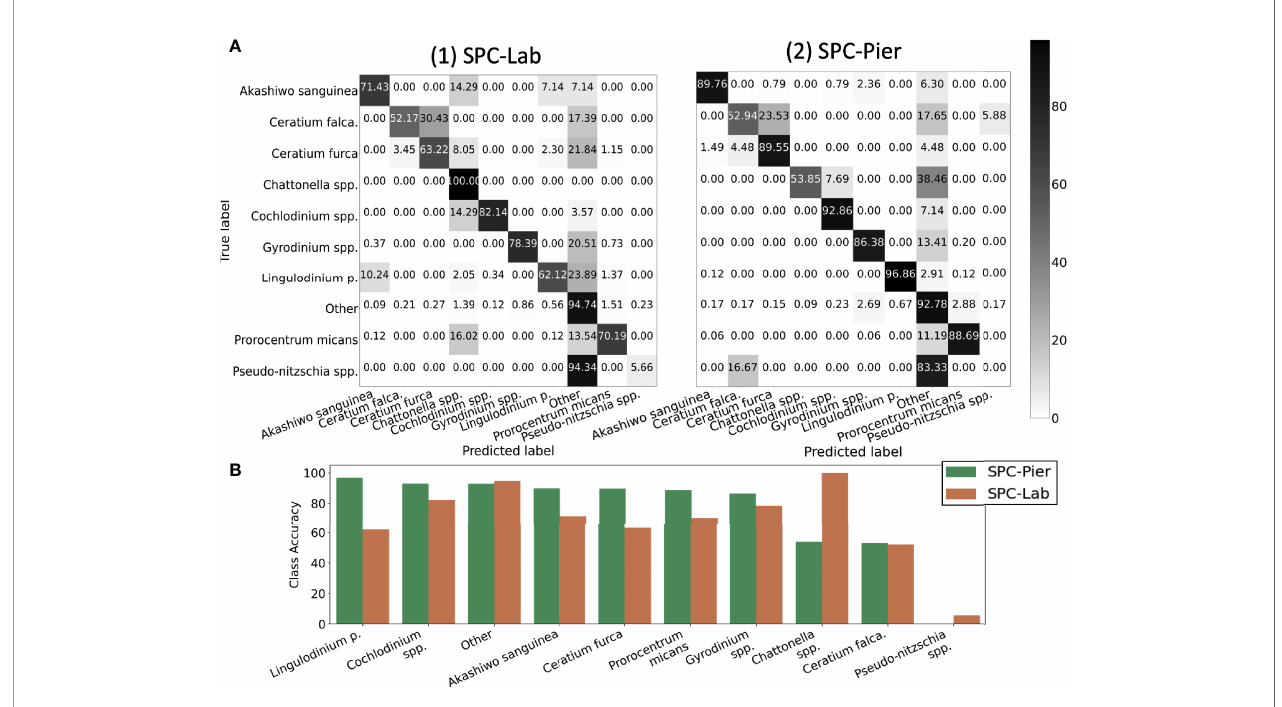
FIGURE 5 | Quanti fi cation of the classi fi cation accuracy for SPC test sets. (A) Confusion Matrix. (B) Diagonal class accuracies of confusion matrix sorted in a descending fashion from left to right.